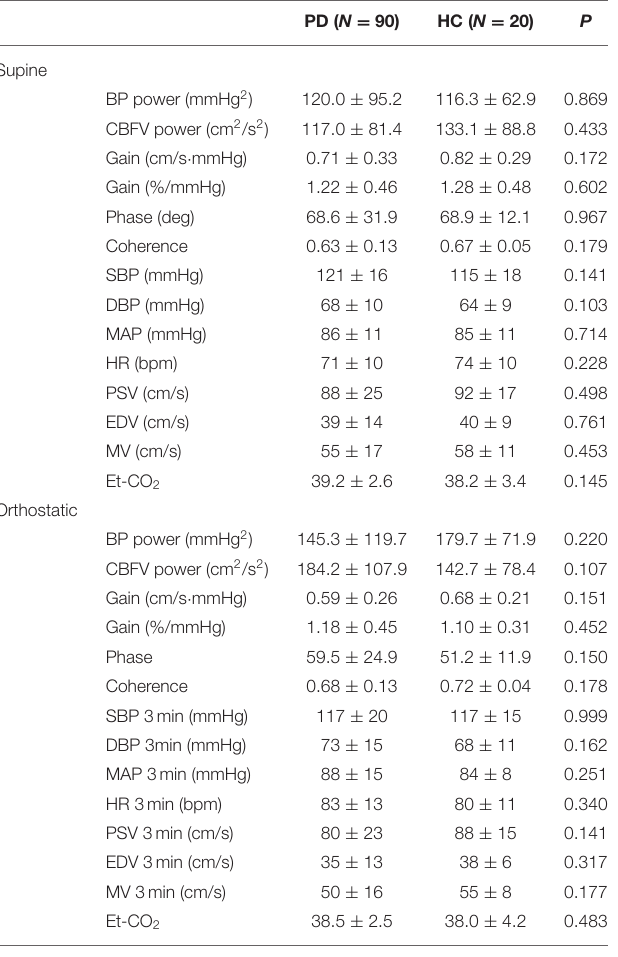
TABLE 2 | Cerebral autoregulation parameter during supine and orthostatic position.